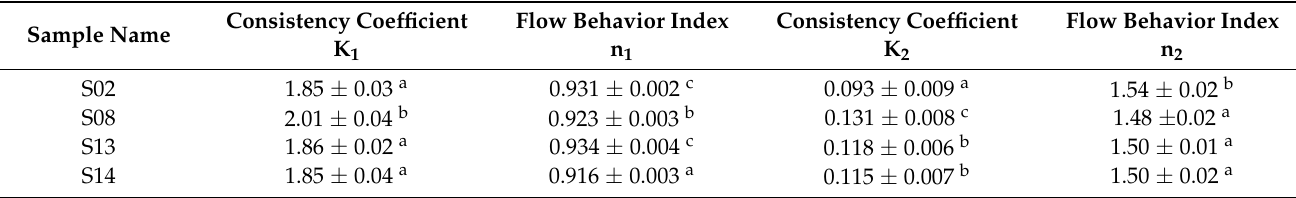
Table 4. Parameters of the broken power model describing the viscosity curves of the samples: consistency coefficient (K 1 and K 2 ), flow index (n 1 and n 2